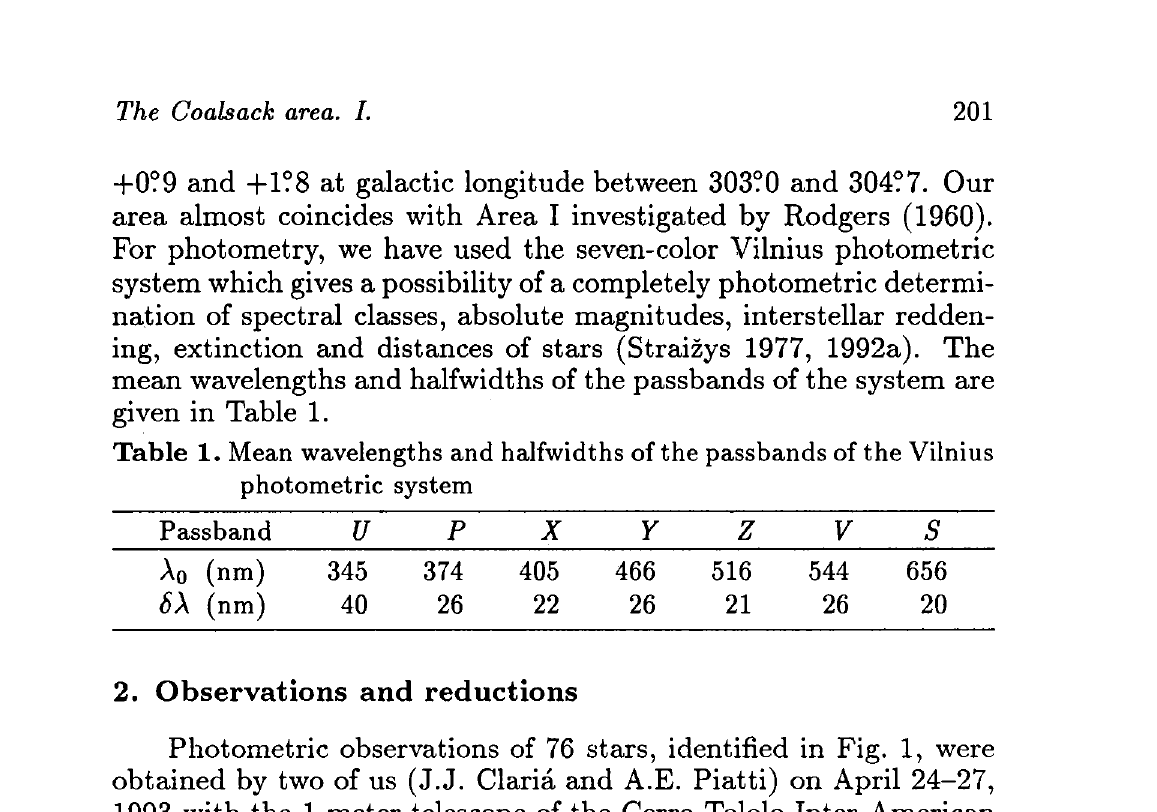
Table 1. Mean wavelengths and halfwidths of the passbands of the Vilnius photometric